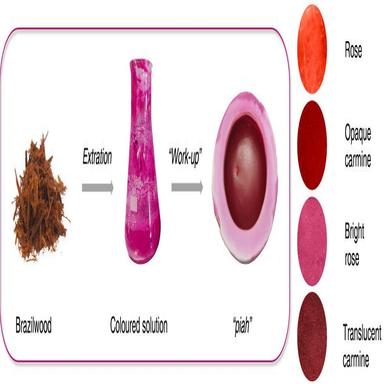
Producing a medieval brazilwood lake pigment. In the four recipes for producing rose colours from brazilwood in The book of all colours, brazilein, the main chromophore in brazilwood, is extracted in an acid or basic medium, which determines the hue of the pigment produced. Alum is added together with additives (lead white, chalk, gypsum) which influence the opacity of the pigment. Filtration of the colored solution over a chalk or gypsum stone (piah feitah de gis o de pedra kri) improves filtration and int